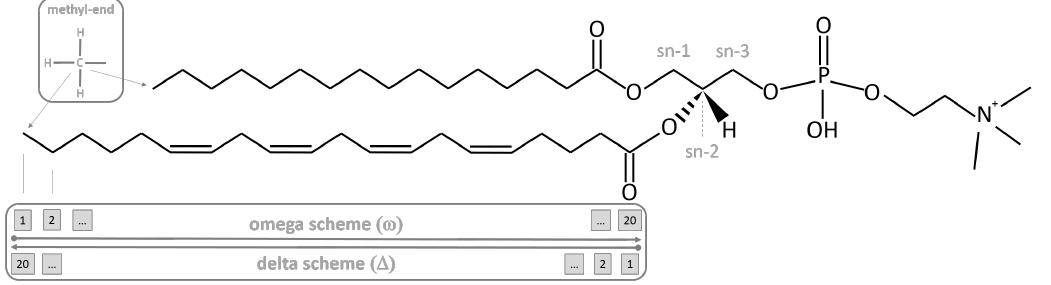
Figure 2: A phosphatidylcholine species which incorporates a fatty acyl 16:0 and a fatty acyl 20:4 (sum composition: PC 36:4; molecular composition: PC 16:0/20:4). The zig-zack structure resem- bles a hydrocarbon chain. Each elbow denotes a CH2 hydrocarbon since carbon is tetravalent. Thus, the tip of a terminal edge denotes a CH3 hydrocarbon (methyl end). Doubled lines indicate a double bond between two carbon atoms. The glycerol backbone consists of three carbon atoms each labeled by its stereospecific numbering (sn). Two schemes ( ω and ∆ ) for counting carbon atoms of the hydrocarbon chain. They are used to denote double bond